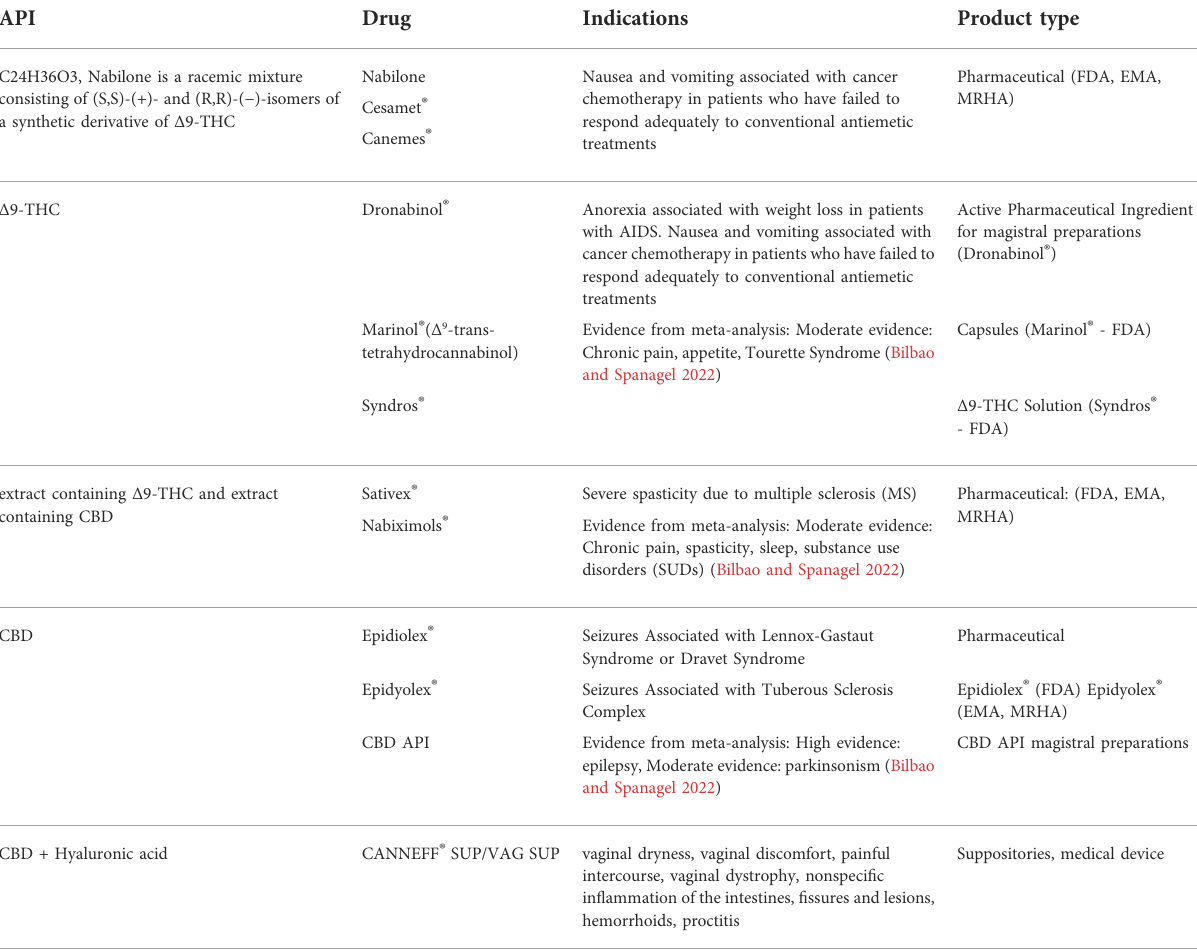
TABLE 3 Approved cannabinoid medications and their active ingredients, indications, and product types. Meta analysis fi ndings from (Bilbao and Spanagel, 2022) are included for “ high ” and “ moderate ” evidence indications. API